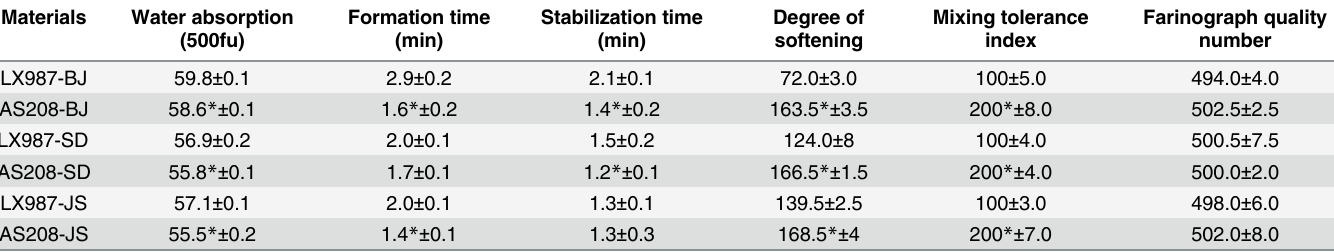
Table 4. Mixograph parameters of AS208 and LX987 in the three experimental locations.